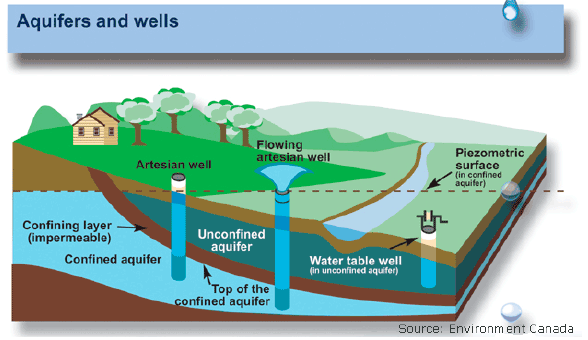
Figure 1. Aquifers and wells.